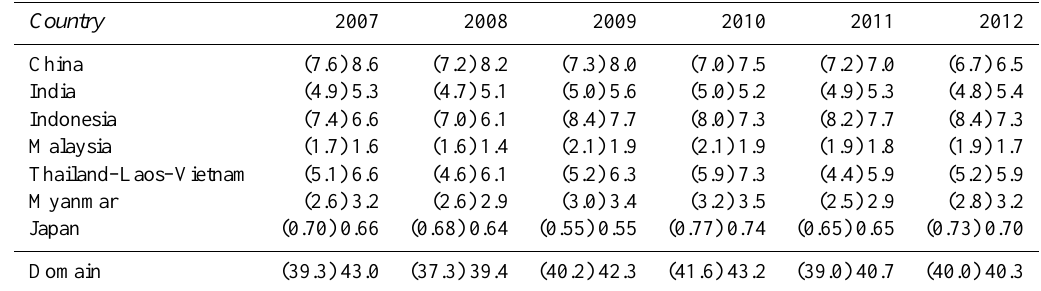
Fig. 12. Annual a priori isoprene emission in 2008 and deviation from the a priori inferred by an inversion constrained by GOME-2 HCHO columns. Units are 10 10 moleccm − 2 s − 1 . The a priori inventory is obtained from the S4 simulation (cf. Sect. 7.1). Table 3. Bottom-up (in parentheses) and top-down annual isoprene emission estimates per country and for the entire studied domain (expressed in Tg of isoprene) between 2007 and 2012. Top-down estimates are inferred by inversion of GOME-2 formaldehyde columns as explained in Sect. 7. The bottom-up estimates are obtained from the S4 simulation (cf. Sect. 7.1). The domain extends from 9.75 ◦ S to 54.75 ◦ N and from 60.25 ◦ E to 149.75 ◦